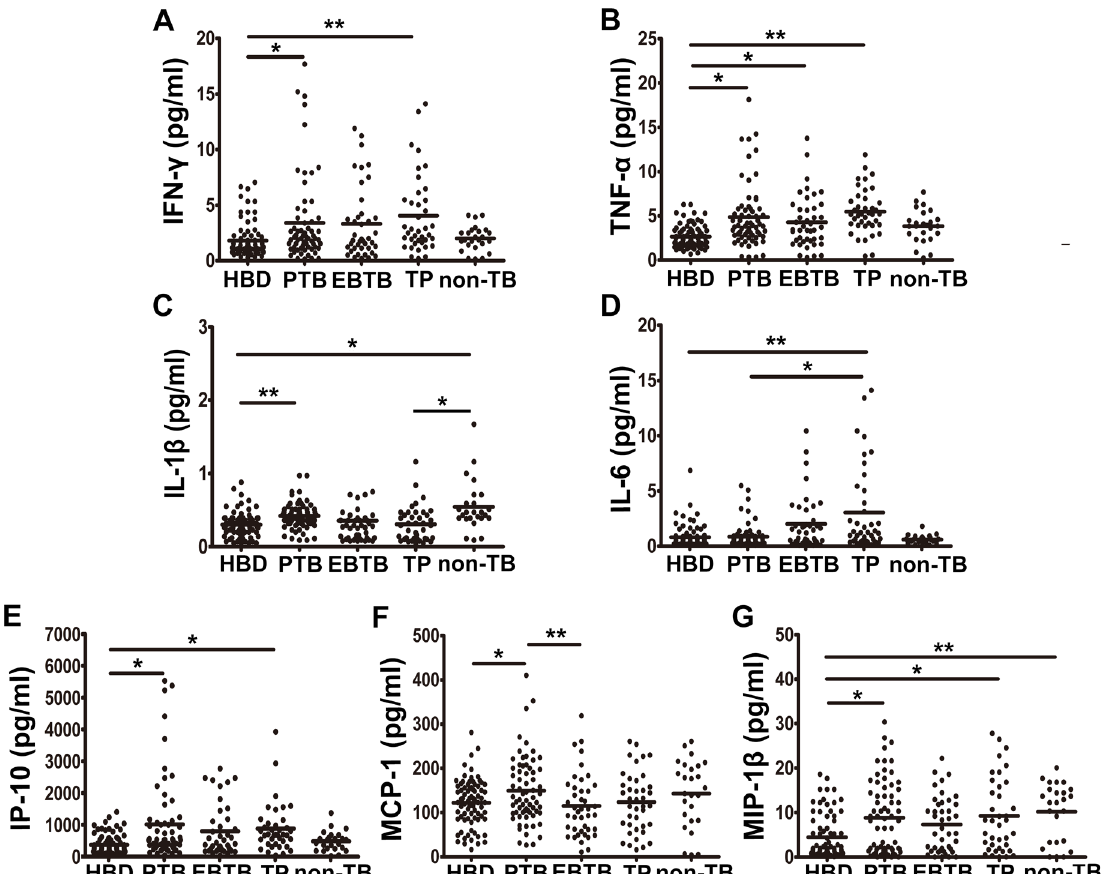
Fig 2. Cytokine/chemokine profiles were established for patients with 3 distinct presentations of TB, for BCG-vaccinated healthy donors (BHD), and for non-TB patients. The levels of (A) IFN- γ , (B) TNF- α , (C) IL-1 β , (D) IL-6, (E) IP-10/CXCL-10, (F) MCP-1, and (G) MIP-1 β are shown. * P < 0.05, ** P < 0.001. P : P value; ANOVA, analysis of variance. When the variance between samples was equal, least significant difference (LSD) post-hoc tests were performed. Dunnett ’ s T3 test was used when the variance was not